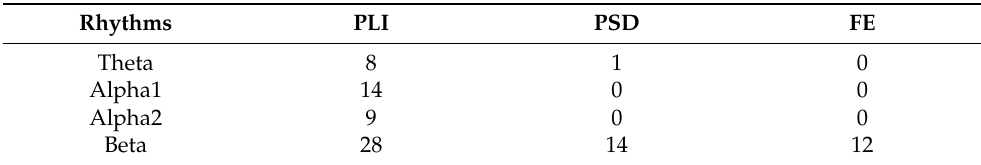
Table 3. Number of features for each rhythm in the multidimensional features within the optimal feature